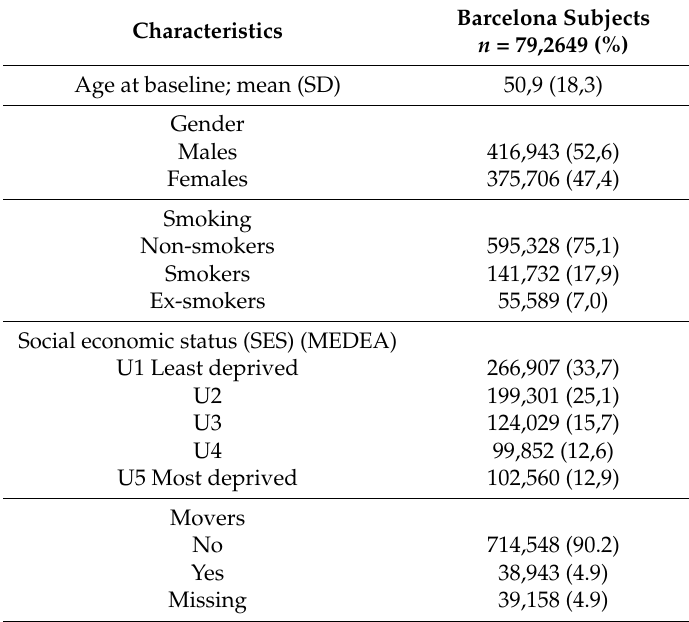
Table 1. Characteristics of the population in